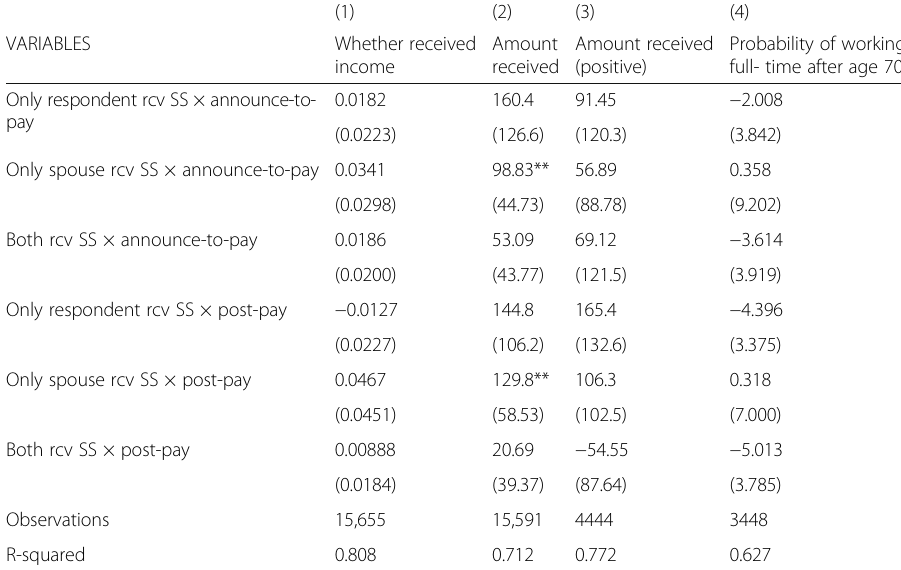
Table 9 Robustness check for labour decisions — accounting for spousal receipt of SSS payout (1) (2)